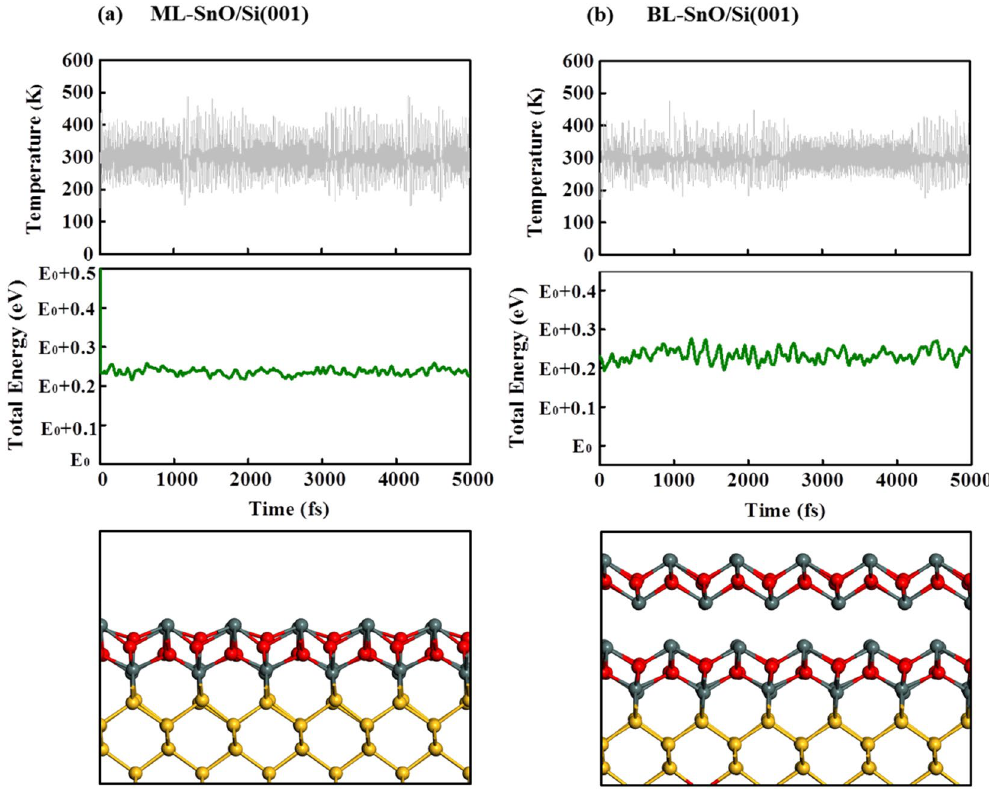
Figure 2. First-principle molecular dynamic calculations at T = 300 K for ML-SnO ( a ) and BL-SnO ( b ) on Si(001) surface. The top panel and the middle panel represent the temperature and total energy respectively as a function of time. The bottom panel shows the snapshot of the corresponding molecular dynamic